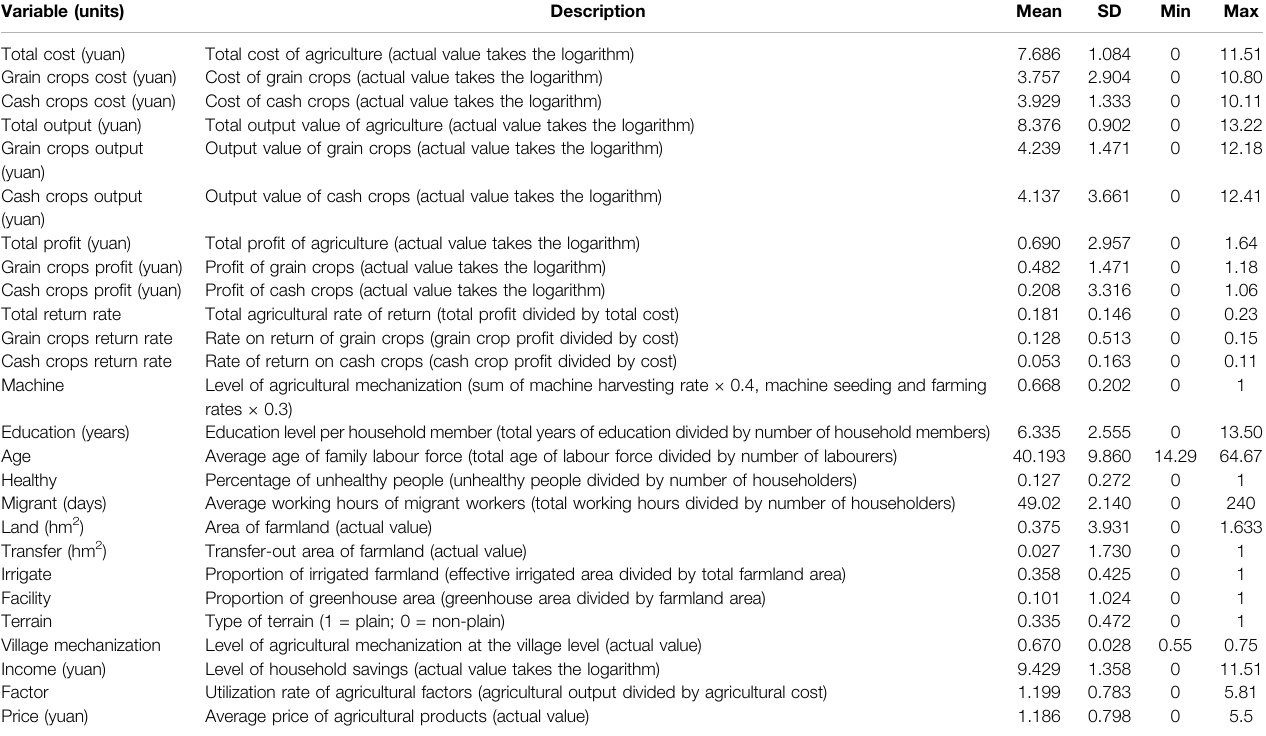
TABLE 1 | Descriptive statistics of the data used in this study. Variable (units) Description